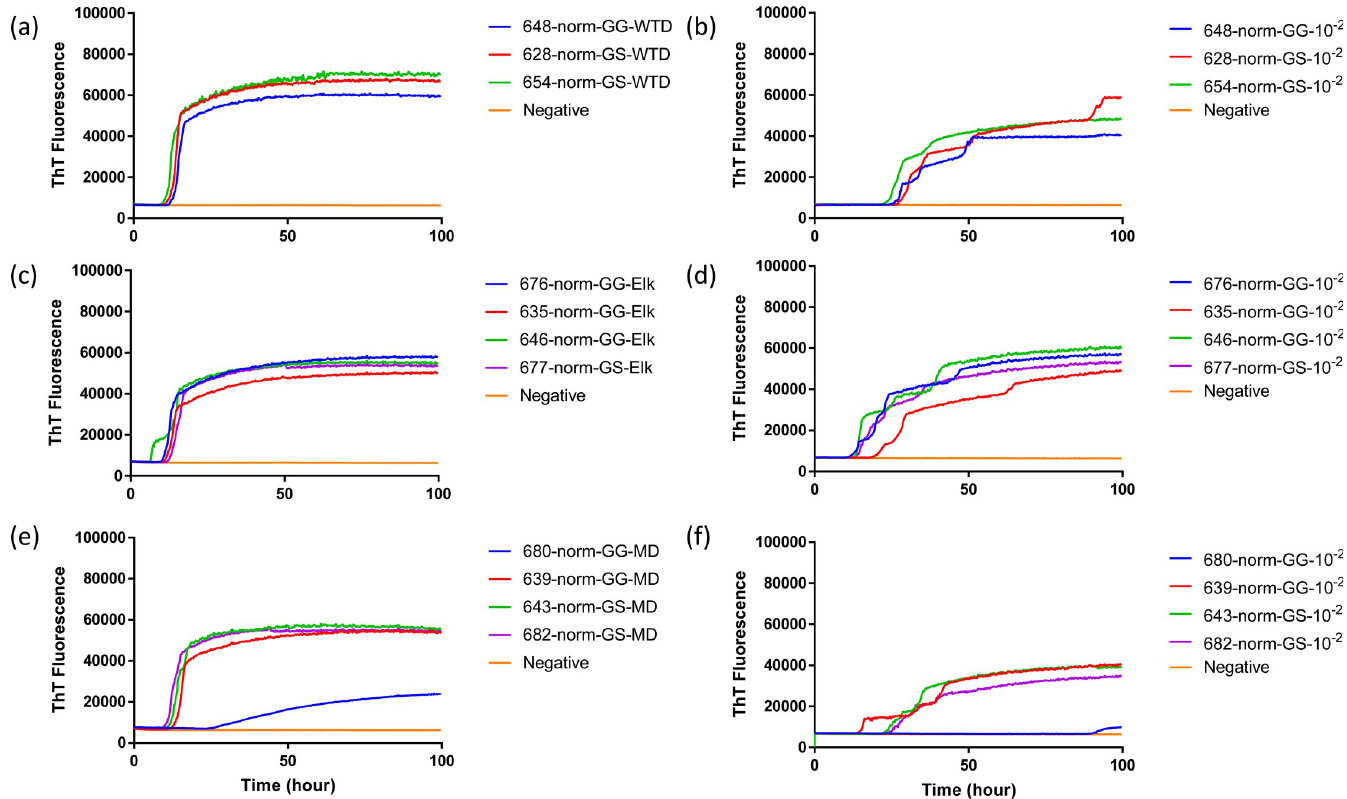
Fig 2. Comparison of seeding activity of RT-QuIC reactions with BV rPrP which contain seeds from WTD inoculated with brains of infected WTD (a and b), elk (c and d) or mule deer (e and f). Left panel shows RT-QuIC reactions seeded with EIA normalized brains and right panel shows RT-QuIC reactions seeded with 10 − 2 dilutions of brains. Data are presented as mean ThT fluorescence of 4 repeated reactions.